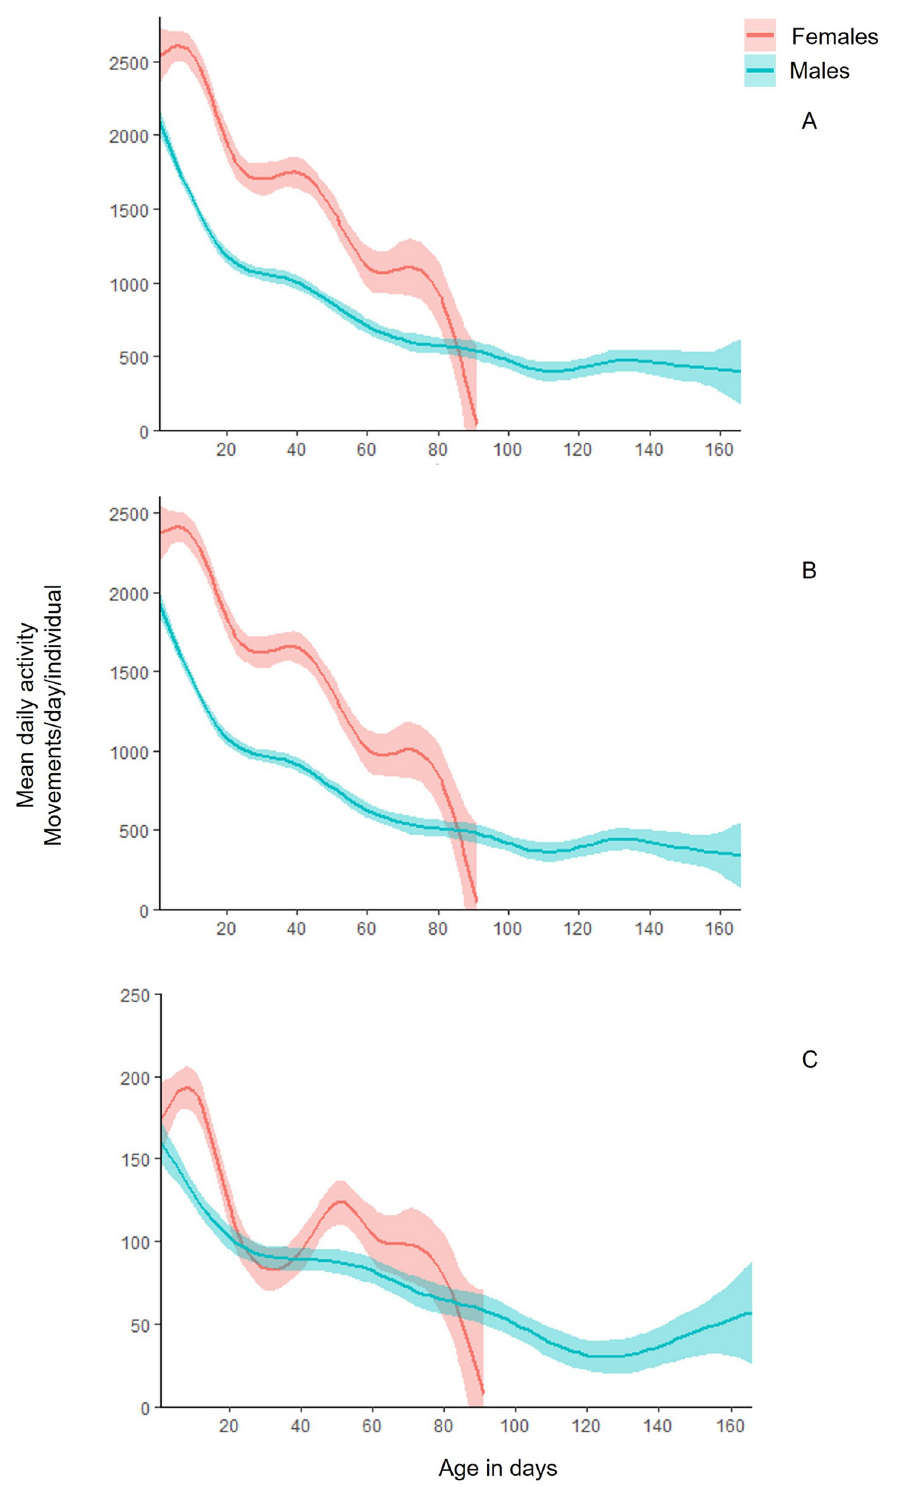
Fig 4. LOESS curves (Locally Estimated Scatterplot Smoothing curves) for mean activity of males (blue) and females (red) with 95% Confidence Intervals (CI), during the 24h period (A), daytime (B) and nighttime (C). Mean activity was estimated by the sum of movements of all individuals during the period of interest (24h, daytime, nighttime), divided by the number of individuals surviving on each day. https://doi.org/10.1371/journal.pone.0269940.g004 PLOS ONE | https://doi.org/10.1371/journal.pone.0269940 July 25,